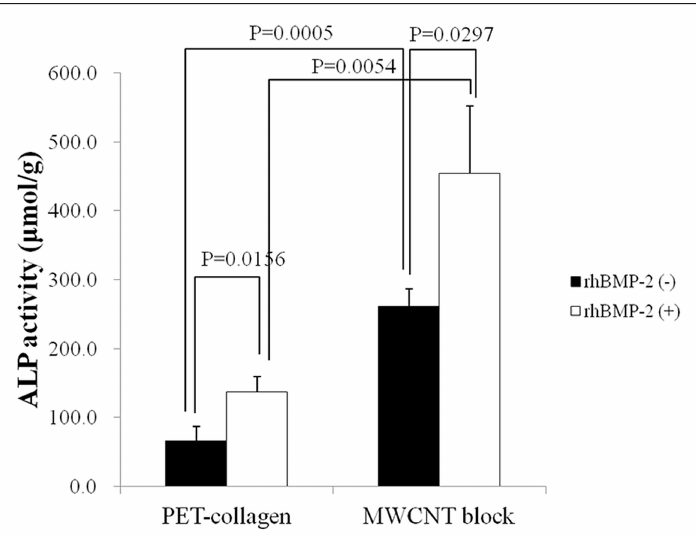
Fig 11. ALP activity. Graph shows the ALP activity of MC3T3-E1 cultivatedon MWCNT blocks and PET- reinforcedcollagensheets in the presenceand absenceof rhBMP-2. Values are mean ± S.D.; n = 3.